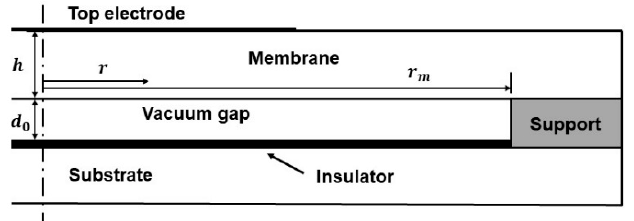
Figure 1. Schematic diagram of a typical capacitive micromachined ultrasonic transducer (CMUT) cell (C1). cell